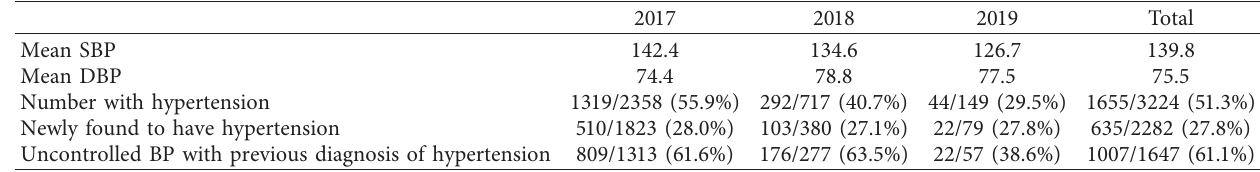
Table 2: Mean BP of participants using the first reading.